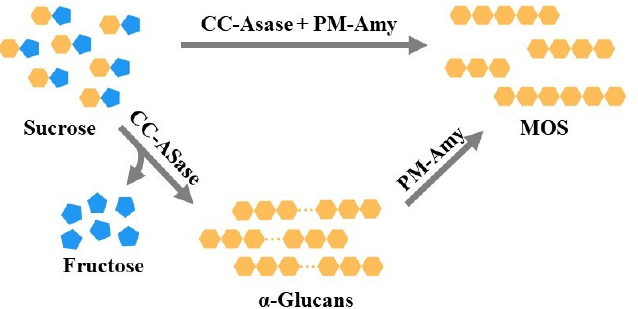
Figure 6. The reaction mechanism associated with MOS production from sucrose. Adapted with permission from Ref. [124] . 2018, Elsevier.